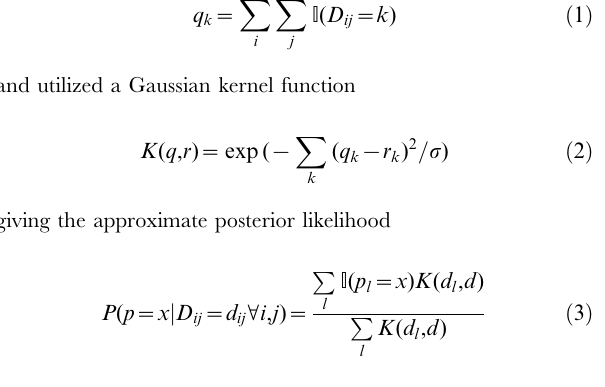
table of simulated MLST data for different values of p . This allowed us to approximate P ( D j p ) and P ( ~ DD j p ) , where D denotes the data - a matrix of pairwise distances - and ~ DD denotes the vector describing the distribution of D